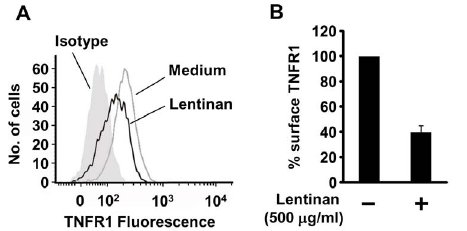
Figure 4. Lentinan suppresses cell surface levels of TNFR1 in Caco-2 cells. Lentinan (500 m g/ml) was added into the apical compartment of Caco-2/RAW264.7 co-culture model for 30 min. Subsequently, Caco-2 cells were harvested, fixed, and stained according to the method described in materials and methods. (A) Surface levels of TNFR1 were analyzed by flow cytometry. (B) The resulting gMFIs were plotted as percentages of the gMFI obtained from medium treated cells, with the following fomula: % surface TNFR1=(lentinan gMFI – isotype control gMFI)/(medium gMFI – isotype control gMFI) 6 100. The values represent the means 6 SE. Experiments were repeated for three times in triplicate.